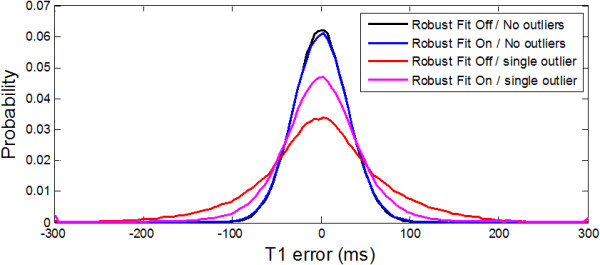
Histogram of T1 errors for case of T1 = 1000 ms, SNR = 30 illustrating the difference between iteratively re-weighted robust fitting in the presence of outliers.